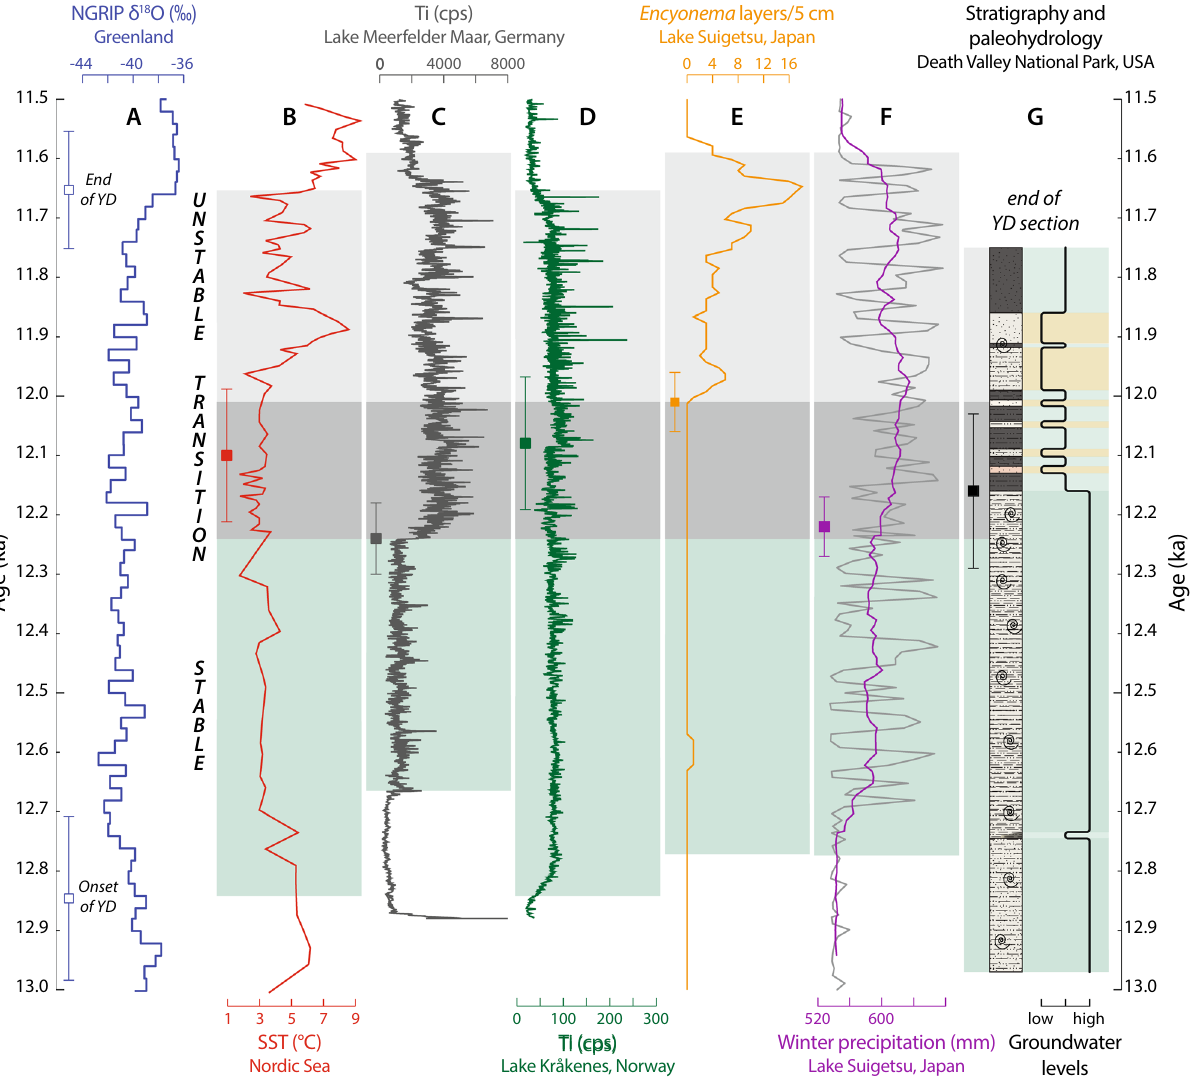
Figure 4. Paleospring record from Death Valley National Park, California (DEVA) compared to other proxy records that exhibit evidence of two-stage partitioning during the Younger Dryas (YD) climate event. Ages for all records are presented in ka (ka = thousands of calendar years before present; 0 ka = 1950 A.D.), and uncertainties are presented at the 95% (2σ) confidence level. Open squares in A show the timing of the onset and end of the YD in the NGRIP ice core record 5 . Filled squares in B-G show the timing of the transition between the two stages of the YD as defined in the original studies with the corresponding 2σ uncertainties. Dark green bands show the stable phase of the event for each record, the light gray bands denote unstable conditions, and the dark gray bands encompass the full temporal range of the transition between the two stages. ( a ) Oxygen isotope (δ 18 O) values from the NGRIP ice core using the GICC05 chronology 5 . ( b ) Sea-surface temperatures (SSTs) reconstructed from planktonic foraminiferal assemblages in marine core MD99-2284 off the coast of Norway 16 . ( c ) Micro–X-ray fluorescence (XRF) measurements of Ti (in counts per second; cps) in sediments from Lake Meerfelder Maar, Germany as a proxy for detrital flux in spring snowmelt 14,18 . ( d ) Ti in sediments from Lake Kråkenes, Norway as a proxy for mass turnover rates of the Kråkenes glacier 16,18 . ( e ) Layers rich in the diatom Encyonema in sediments from Lake Suigetsu, Japan as a proxy for wind strength and turbulence 20 . ( f ) Pollen-based reconstruction of winter precipitation at Lake Suigetsu 20 . ( g ) Composited stratigraphy (left) and inferred groundwater levels (solid black line, right) of the DEVA paleospring deposits (this study). On the far right, dark green bands represent stable, long-lived spring ecosystems; light green bands denote short-lived springs; tan bands mark periods of